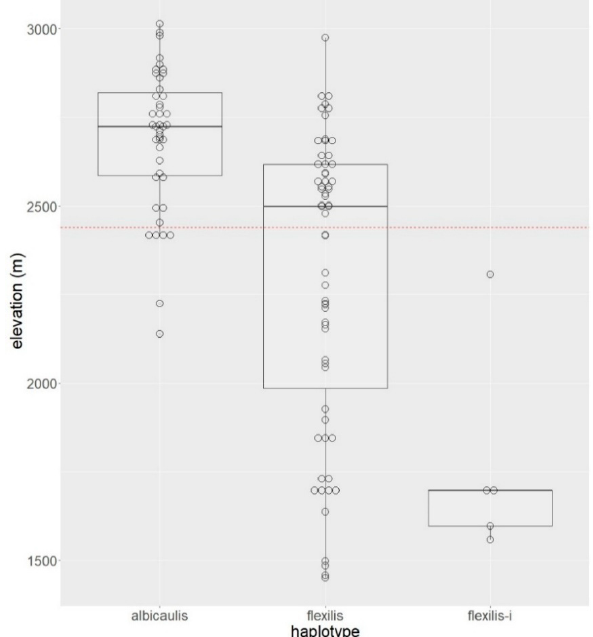
Figure 5. Dotplots with boxplot overlays showing the range of elevation for each of the three chloroplast DNA psbA-trnH haplotypes ( n = 43, 63, and 5 for the “albicaulis”, “flexilis”, and “flexilis-i” haplotypes, respectively). The box captures 50% of the data points and the thick horizontal bar represents the median. Data points above and below the whiskers represent outliers. The red dashed line represents the 2440 m threshold above which five-needle pines lacking cones conventionally are assigned to whitebark pine.